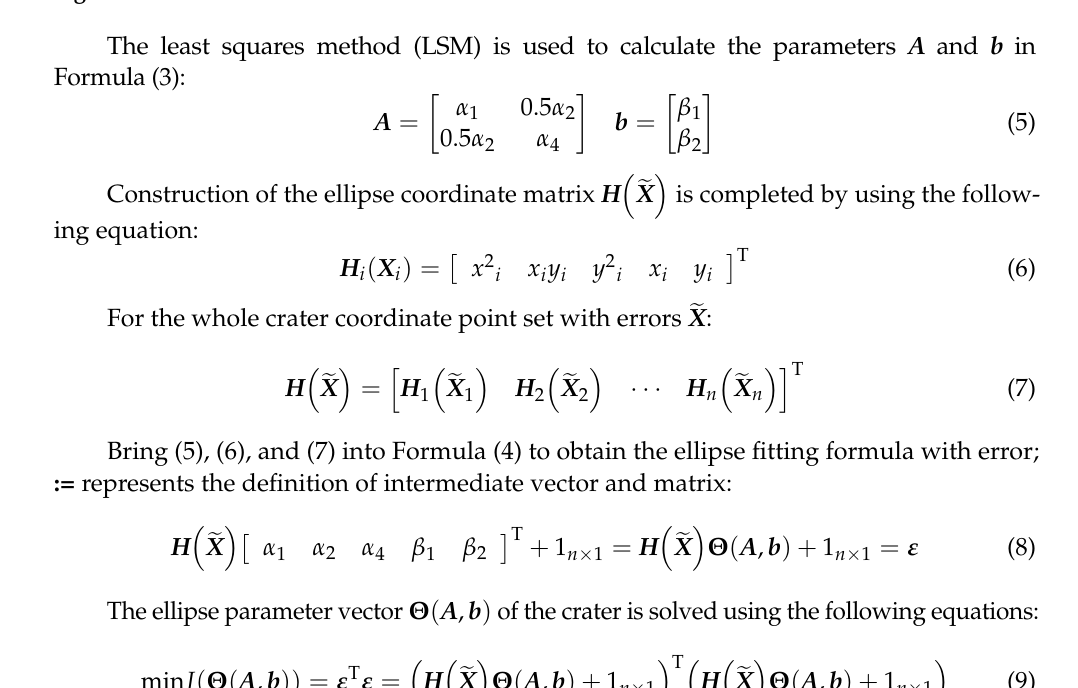
Figure 2. Crater detection results.